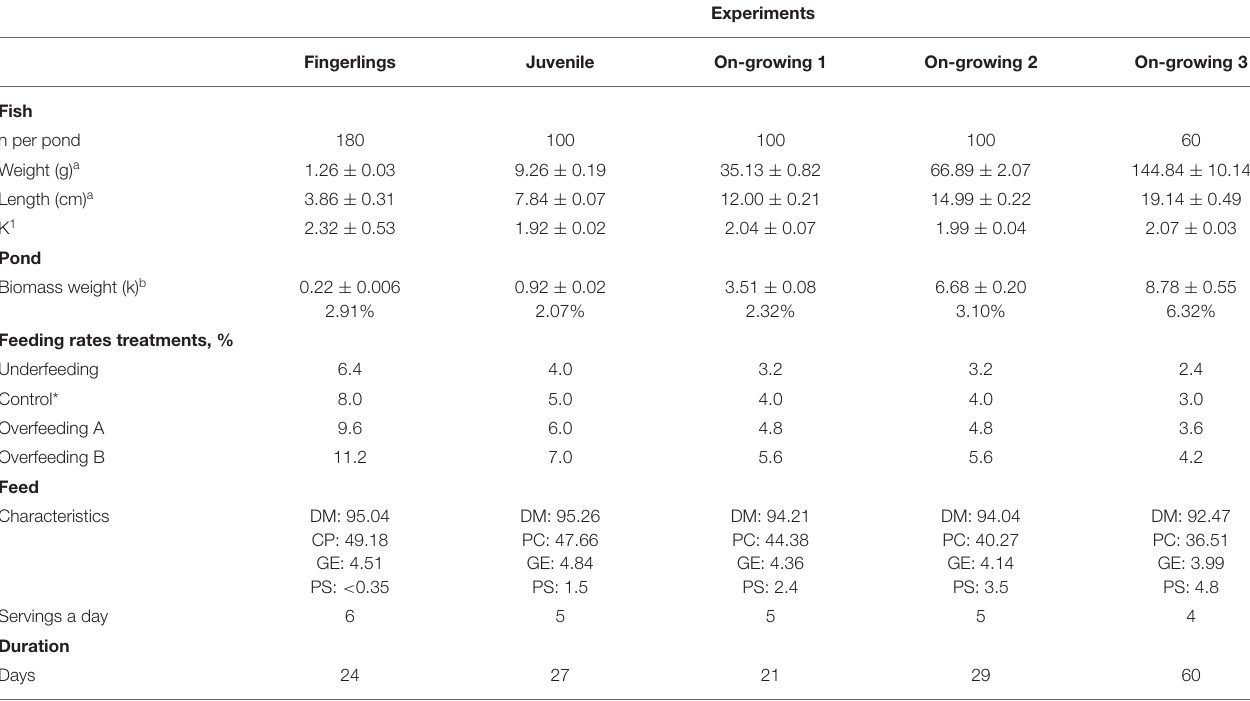
TABLE 1 | Experimental design: initial values of the number of fish per pond, weight, length, and